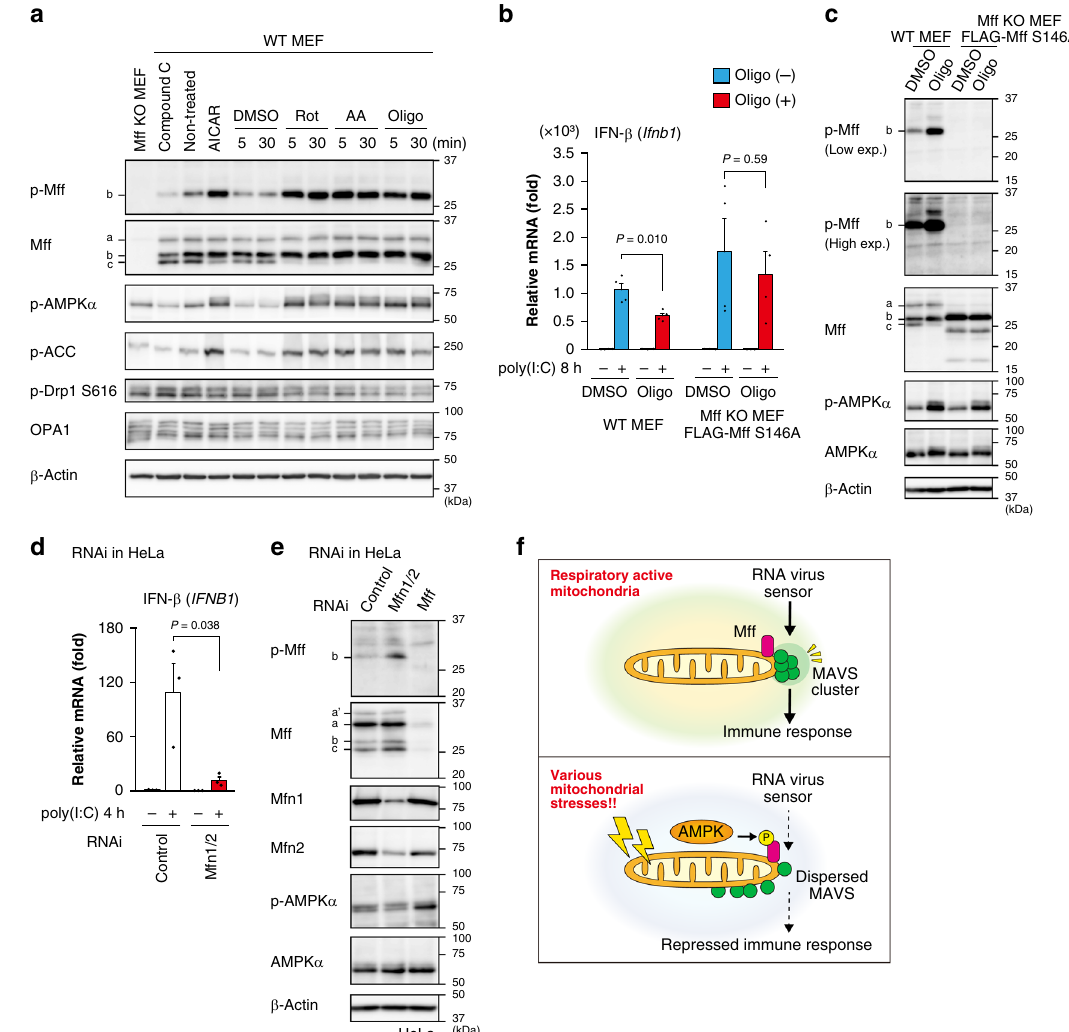
Fig. 6 Mitochondrial dysfunction leads to Mff phosphorylation and impaired antiviral response. a WT MEFs were treated with the respiratory inhibitors rotenone (Rot, 0.5 μ M) or antimycin A (AA, 1 μ M) or the ATP synthase inhibitor oligomycin (Oligo, 1 μ M) for 5 or 30 min. Whole-cell lysates were analyzed by immunoblotting using antibodies against the indicated proteins. AICAR (2 mM) or compound C (20 μ M) was used as an AMPK activator or inhibitor, respectively. DMSO: dimethyl sulfoxide. b qRT-PCR analysis of IFN- β mRNA with or without poly(I:C)-LMW in WT MEFs and Mff KO MEFs stably expressing FLAG-Mff S146A. Cells were pretreated with or without oligomycin (Oligo, 1 μ M) for 30 min and then transfected with poly(I:C)-LMW (1 μ g/mL) in the absence ( − ) or presence ( + ) of oligomycin for 8 h. Data represent means ± SEM of two independent experiments ( n = 4, P values; two- tailed unpaired t test). c Immunoblot analyses of Mff and Mff phosphorylation in WT MEFs and Mff KO MEFs stably expressing FLAG-Mff S146A with or without oligomycin (1 μ M, 30 min). The indicated letters (a, b, c) correspond to the endogenous Mff bands observed in WT MEFs. d HeLa cells were transfected with control or Mfn1/2 siRNA and cultured for 72 h. The cells were transfected with or without poly(I:C)-LMW (1 μ g/mL) for 4 h, and IFN- β induction was analyzed by qRT-PCR. Data represent means ± SEM of three independent experiments ( n = 3, P values; two-tailed unpaired t test). e Analysis of Mff phosphorylation by immunoblotting using anti-phospho-Mff and anti-Mff antibodies in HeLa cells with the indicated RNAi. The ef fi ciency of RNAi and AMPK activation were also examined by each antibody. f Working hypothesis for how mitochondrial dysfunction leads to the suppression of the antiviral response by the AMPK – Mff axis. Immunoblot analyses were repeated independently three times with similar results. Source data are provided as a Source data fi